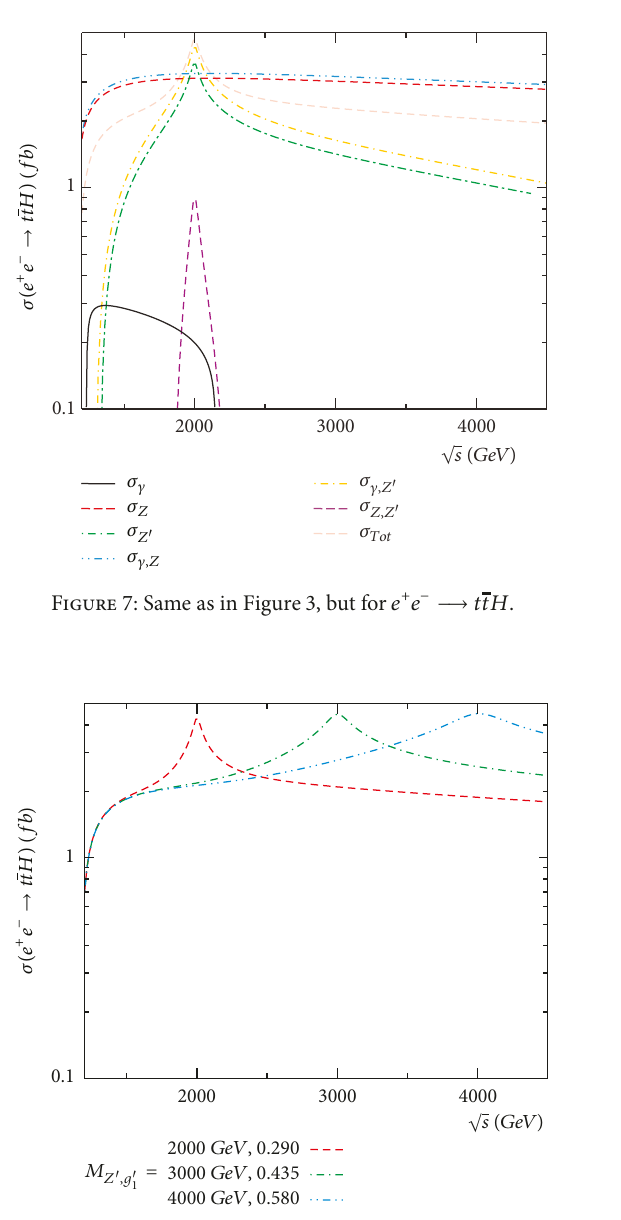
Figure 8: Same as in Figure 4, but for 𝑒 + 𝑒 − 󳨀→ 𝑡𝑡𝐻 .